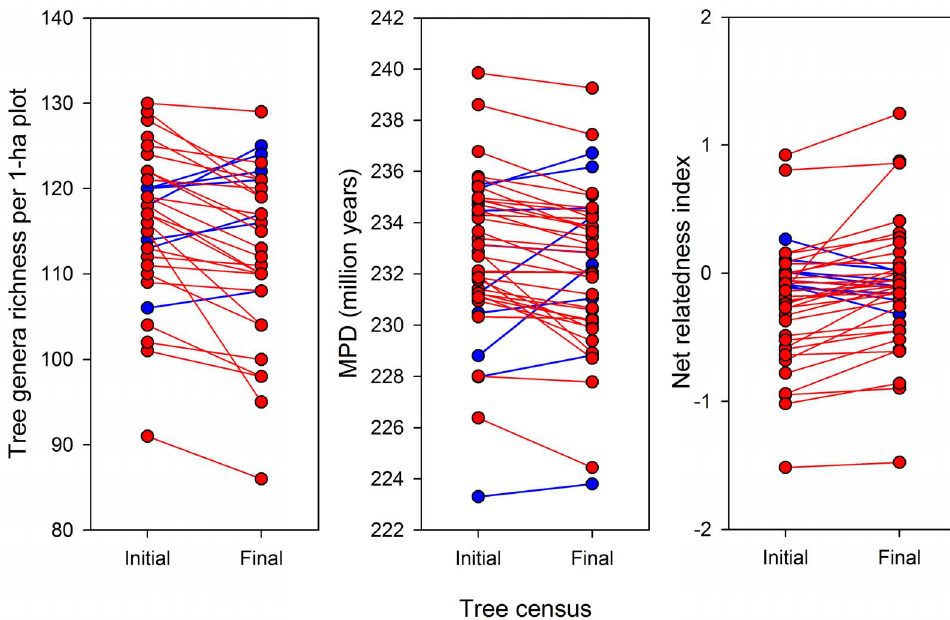
Figure 1. Tree genera richness and phylogenetic metrics of 40 1-ha tree communities in forest fragments and continuous forest in a 1000-km 2 forest landscape of Central Amazonia, Brazil. Initial tree census refers to the first tree inventory carried out before forest isolation in early 1980’s; final tree census refers to the last census available in our dataset (on average 14 years after the first census, see Methods). Red lines indicate loss of tree genera and phylogenetic diversity over time.